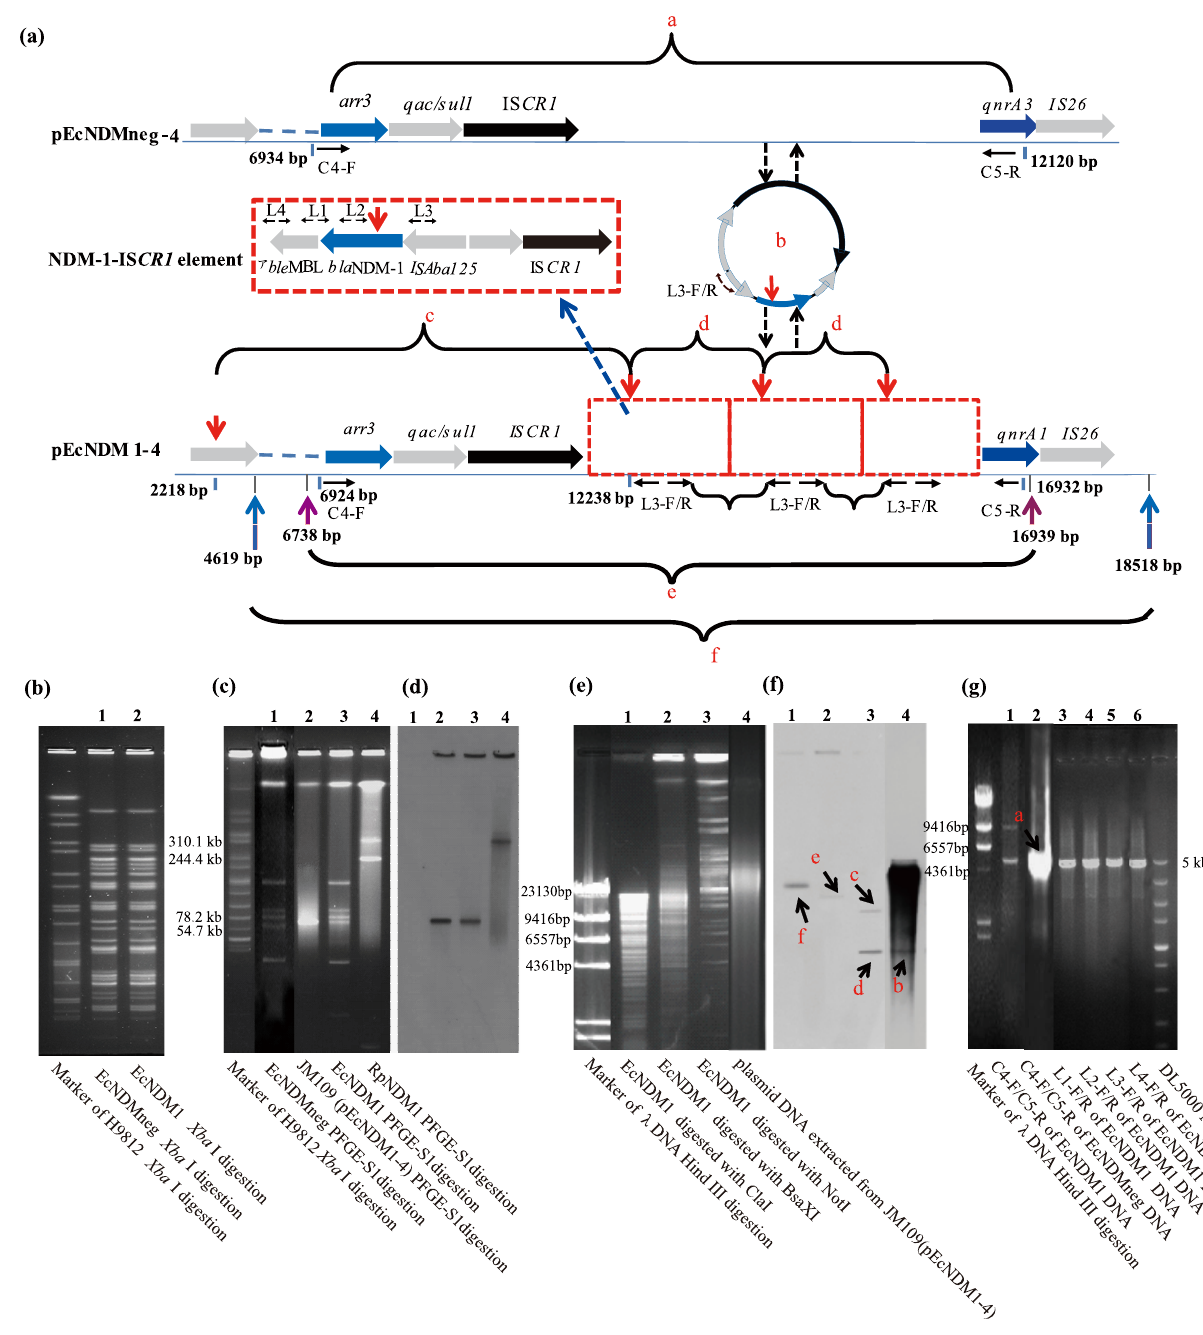
Figure 2. The characterization and mobilization model of the 4812 bp NDM-1-IS CR1 element. ( a ): Genetic context of plasmids pEcNDM1- 4 and pEcNDMneg-4 and mobilization of the 4812 bp NDM-1-IS CR1 element. Red boxes denote 4812 bp NDM-1-IS CR1 element; Horizontal arrow denote the direction of primers; Red downward pointing arrows denote Not I restriction site; Blue upward pointing arrows denote Cla I restriction site; Purple upward pointing arrows Bsa X1 restriction site; Lowercase red letters denote corresponding fragments in ( f ) and ( g ). ( b ): PFGE of Xba I digested patterns of E. coli strains EcNDM1 and EcNDMneg. ( c ): PFGE of S1 digested plasmid profiles from E. coli EcNDM1, R. planticola RpNDM1 and transformant E. coli JM109 (pEcNDM1-4). ( d ): Southern blot hybridization of ( c ) with a bla NDM-1 probe. ( e ): PFGE of plasmid pEcNDM1-4 with or without restriction enzyme digestion stained with ethidium bromide. ( f ): Southern blot hybridization of ( e ) with a bla NDM-1 probe. Lowercase red letters denote fragments expected as depicted in ( a ). ( g ): PCR amplification for confirmation of the structure of the NDM-1-IS CR1 element with primer pairs as shown in ( a ). doi:10.1371/journal.pone.0089893.g002 which may also partly explain the smear observed in Figure 2e and element with a size of 58 228 bp, due to the limitation of sequence Figure 2f of the total plasmid extract. Note that the assembled assembly that cannot resolve the repeats. pEcNDM1-4 sequence has only one copy of the NDM-1-IS CR1